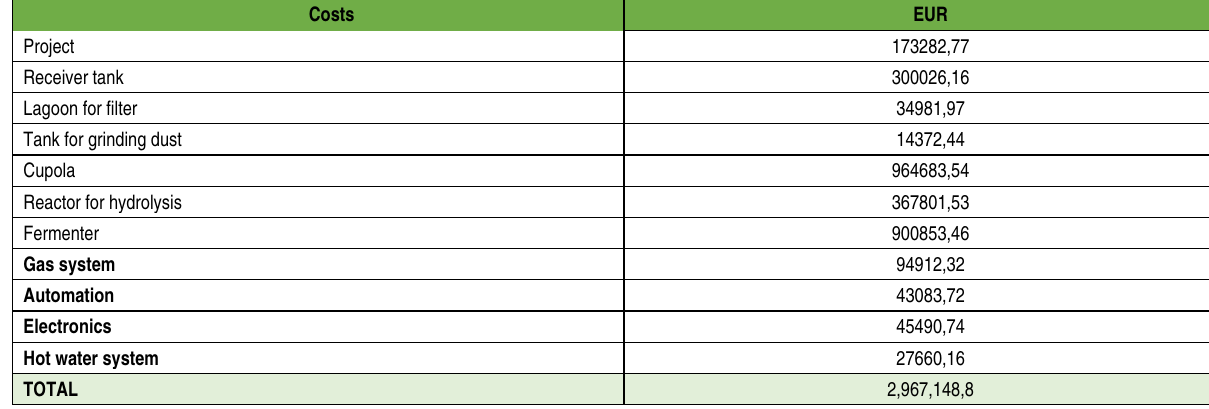
Table 6. The estimated costs of installation the biogas unit and equipment